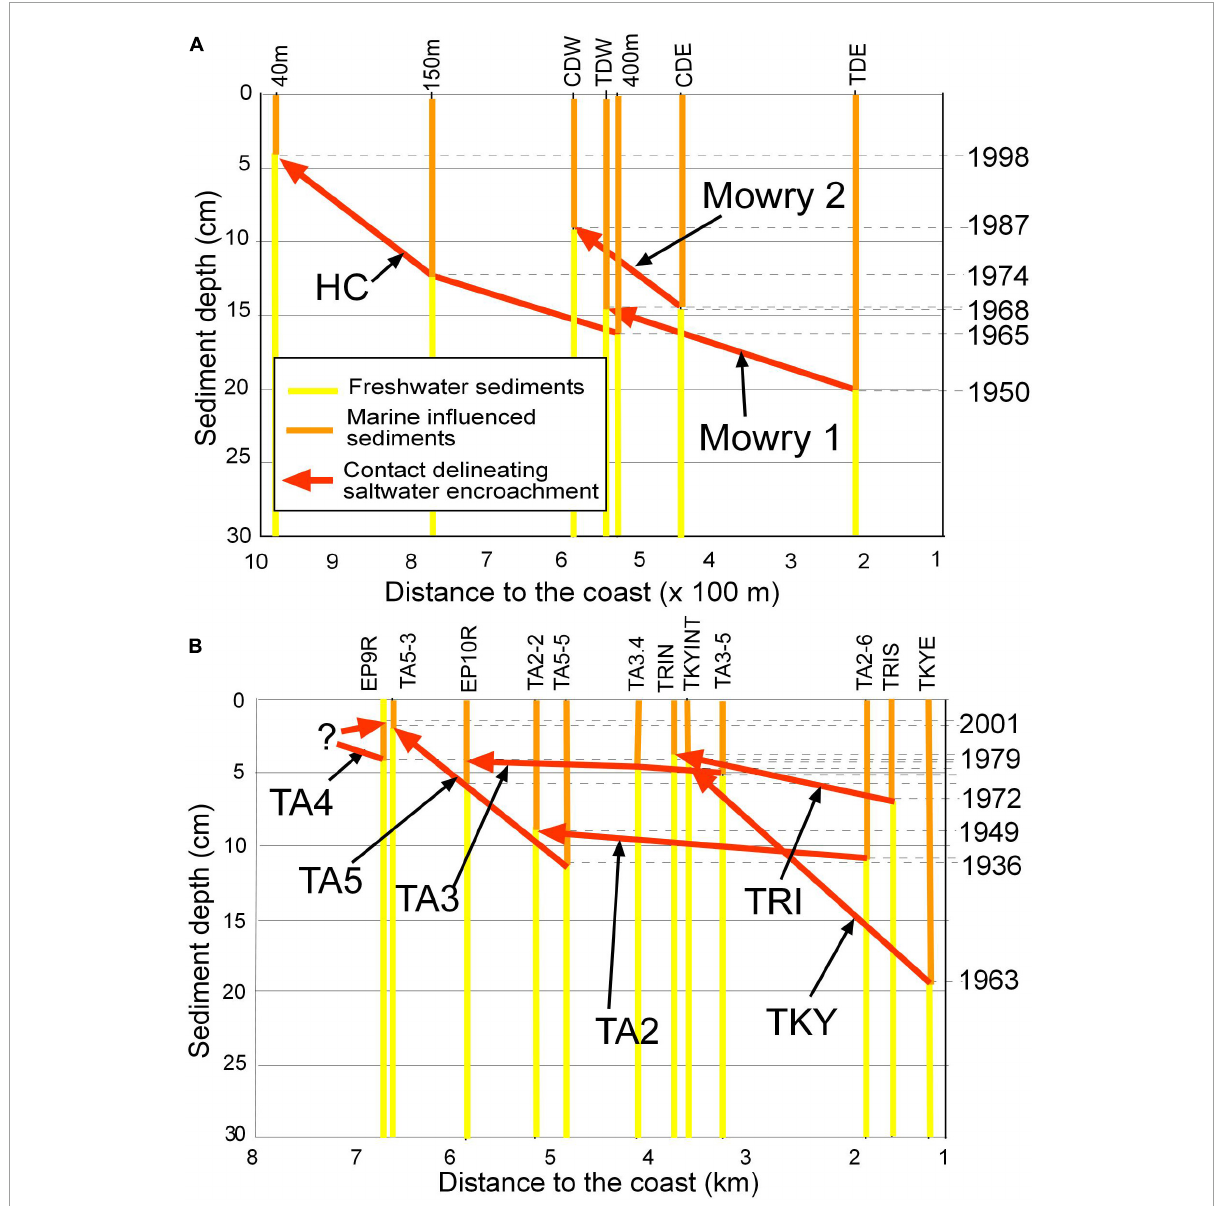
FIGURE4 Core pairs from transects indicating the dates of contacts between core pairs and the distance between the cores. The led line separates freshwater (yellow) from marine influenced (orange) sediments, the arrow points in the direction of saltwater encroachment. (A) Short transects from Biscayne Bay coastal basins. (B) Long transects from Florida Bay coastal basins and the Turkey Point transect from Biscayne Bay. Note the change in horizontal